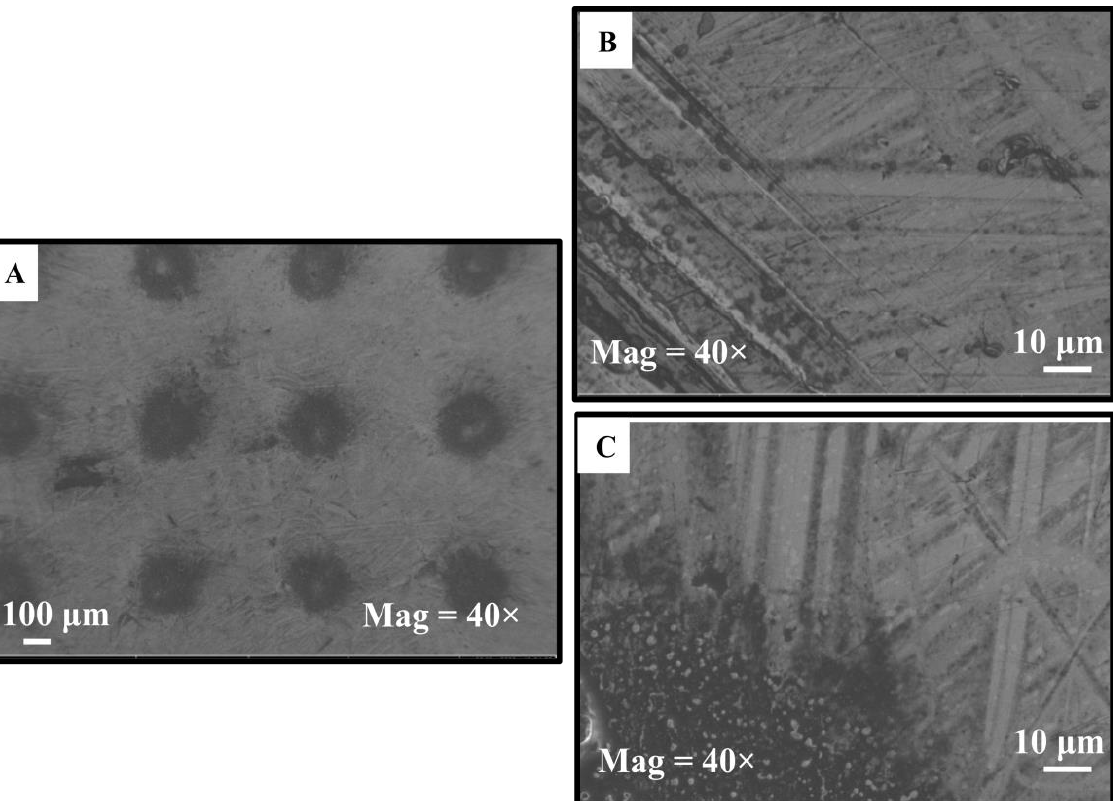
Figure 8. SEM images of ECP_S C specimen showing: ( A ) Textured surface; ( B ) Scratch on the surface and; ( C ) Scratch at the boundary of the texture.